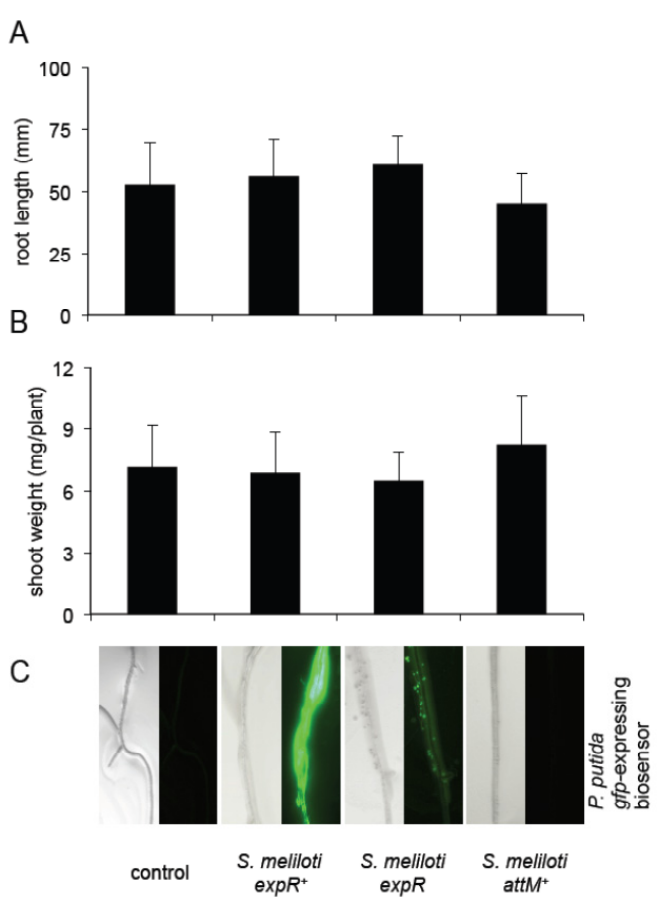
Figure 6. S. meliloti strains producing oxo-C14-HSL has no impact on the growth of Arabidopsis plants . ( A ) Root length of Arabidopsis plants co-inoculated with S. meliloti strains for 9 days; ( B ) Fresh weight of shoots of plants inoculated with S. meliloti strains during 15 days; ( C ) AHL production by S. meliloti strains used in the above experiments on Arabidopsis roots detected by the biosensor bacteria P. putida KS35. Student’s t -test revealed no differences between control and the different treatments, at p ≥ 0.05 in values presented in ( A ) and ( B